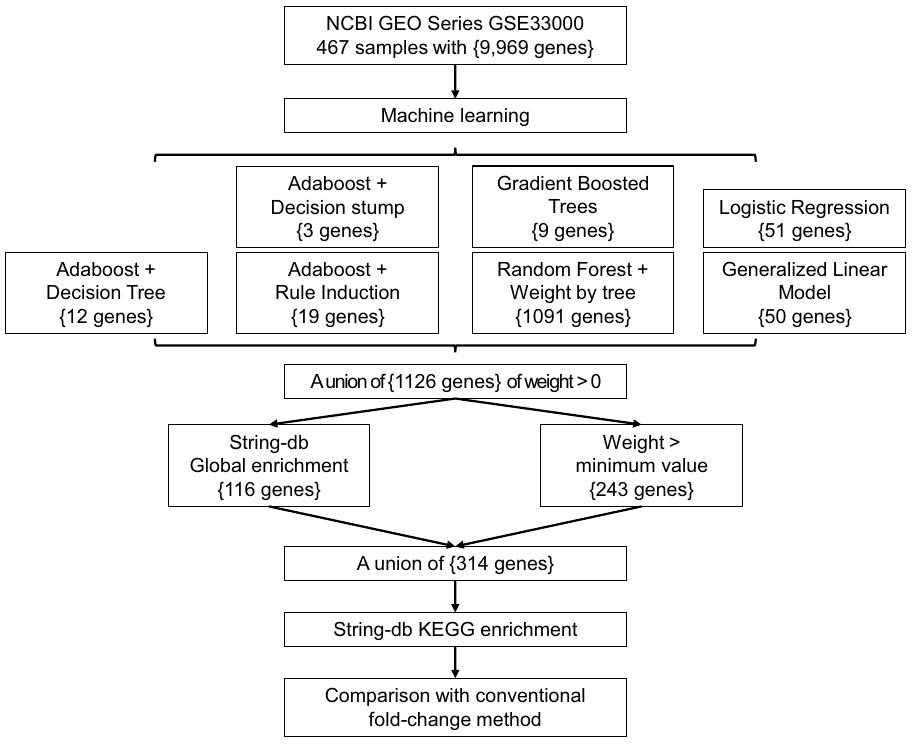
Figure 1. The study design and workflow of identifying AD-predictive genes by ML. The curly brackets indicate the number of genes that passed the criteria or were identified in the ML